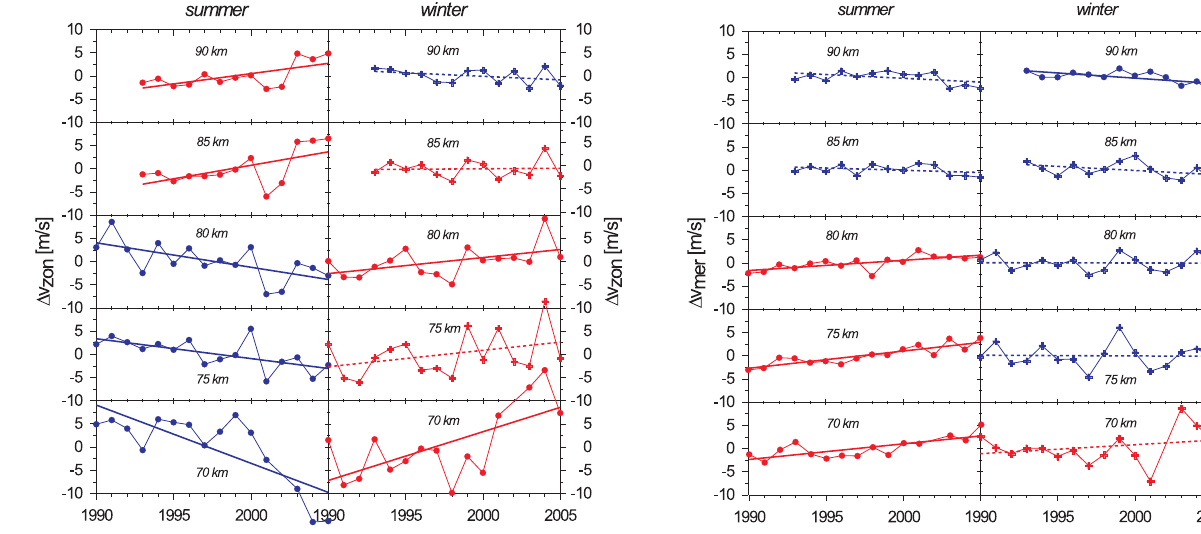
Due to increasing external noise level (mainly foreign radio transmitters) during night-time conditions the radar measure-